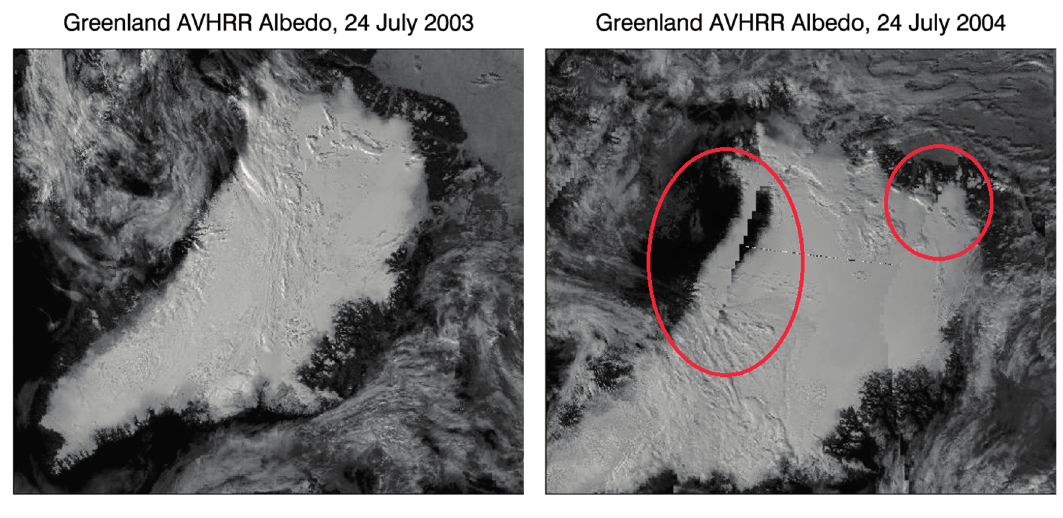
Figure 3. An example of significant geocoding errors. The left panel is a typical albedo image of Greenland during 2003, correctly composited and geocoded. The second panel ( right ) shows severe geocoding errors during mid-summer 2004, most apparent in the circled areas. Note sections of the bad image are repeated and offset, and the entire island has shifted downward in the frame. Both images were obtained from the same Advanced Very High Resolution Radiometer (AVHRR) dataset using similar geographical bounding boxes and projections, and should appear identical except for natural variations in clouds and